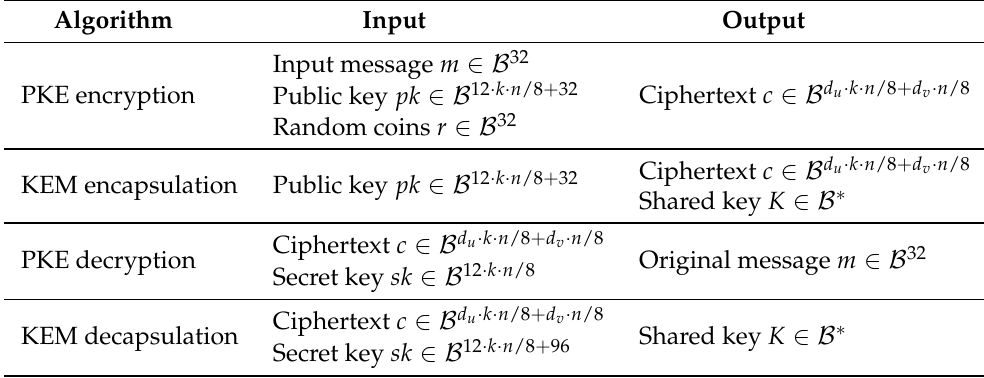
Table 2. Comparison of Kyber PKE encryption/decryption and Kyber KEM encapsulation/decapsulation